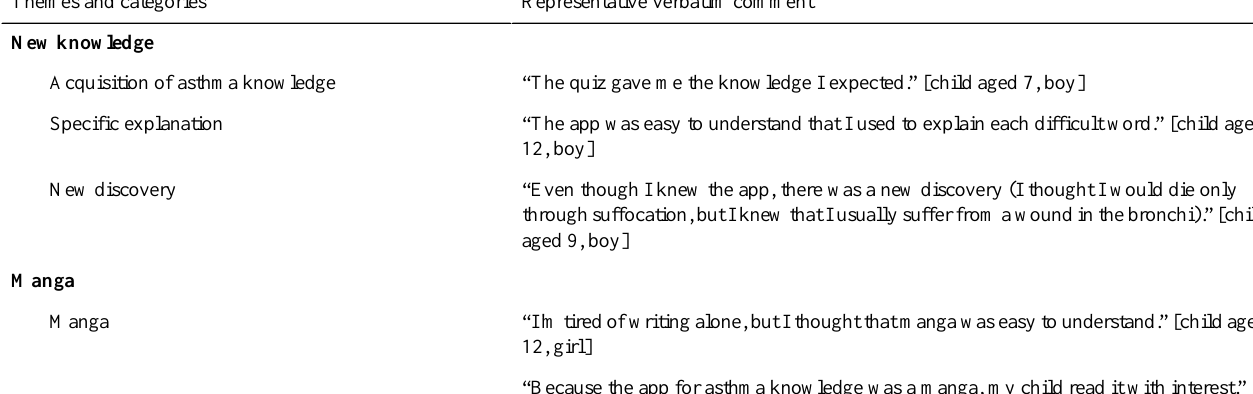
Representative verbatim commentThemes and